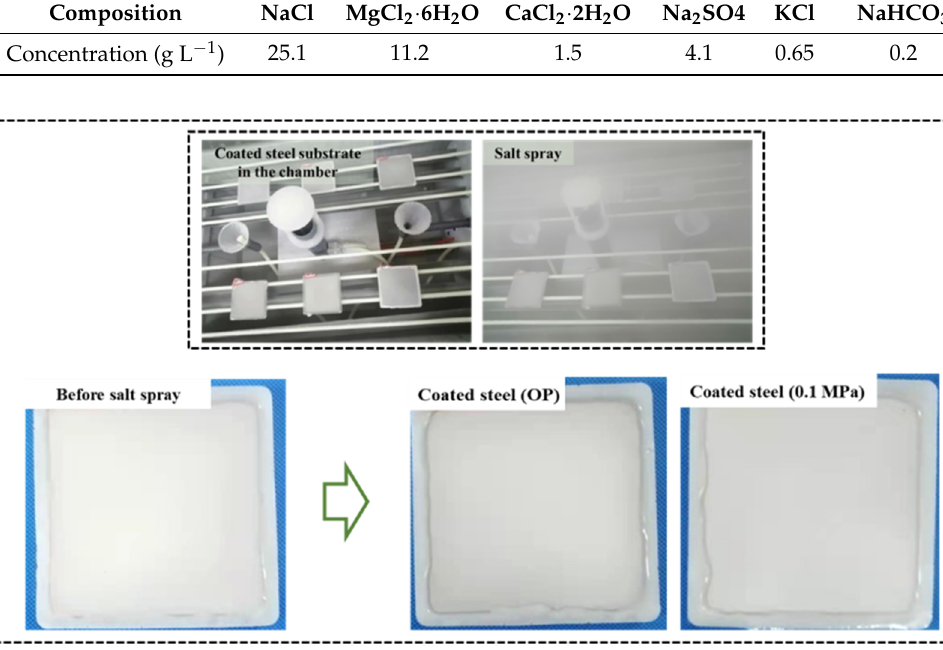
Figure 10. Salt spray test of the coated steel